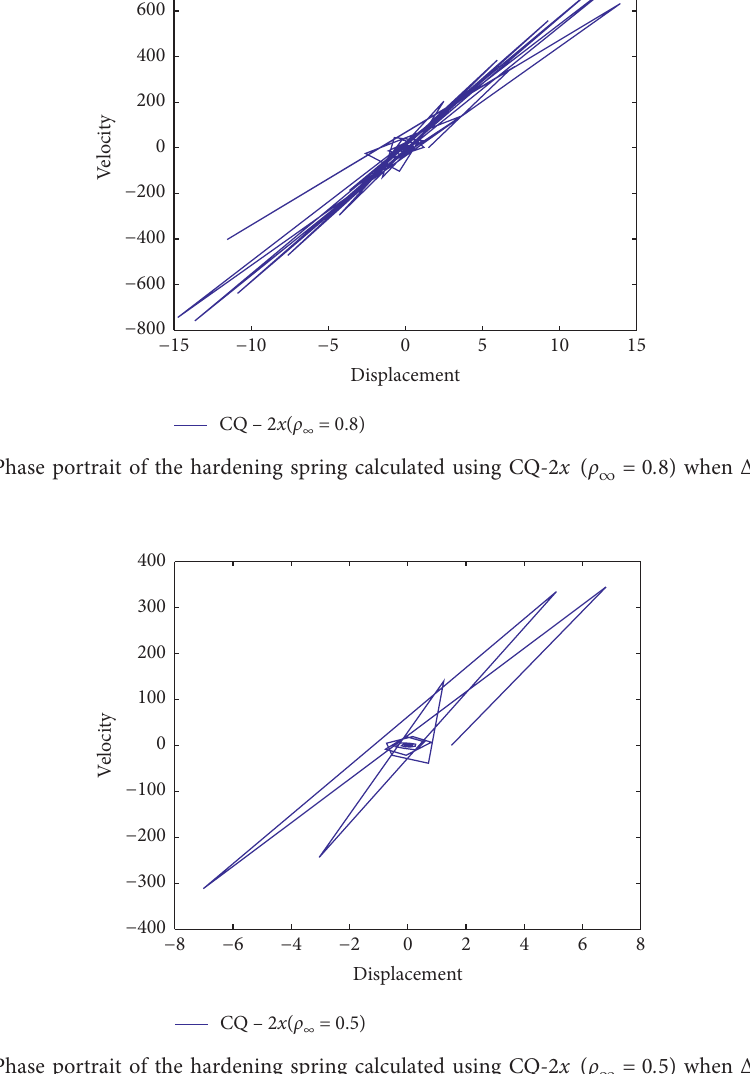
� 0 . 5 ) when Δ t � ( 1/2 ) T ∞